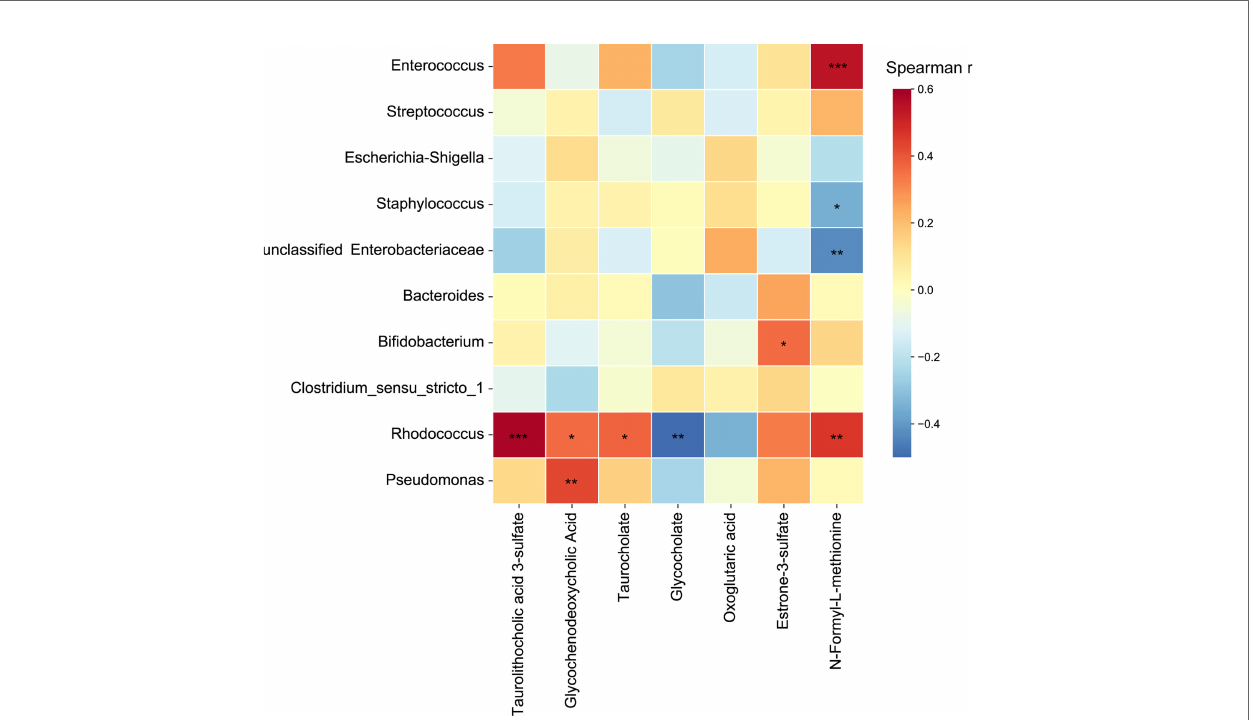
FIGURE 6 | Heatmap of correlation coef fi cients between the top ten genera and metabolites involved in primary bile acid biosynthesis, secondary bile acid biosynthesis, and bile secretion pathways. Signi fi cant correlations are represented by ‘ * ’ with FDR corrected P < 0.05, ‘ ** ’ with FDR corrected P < 0.01, and ‘ *** ’ with FDR corrected P <